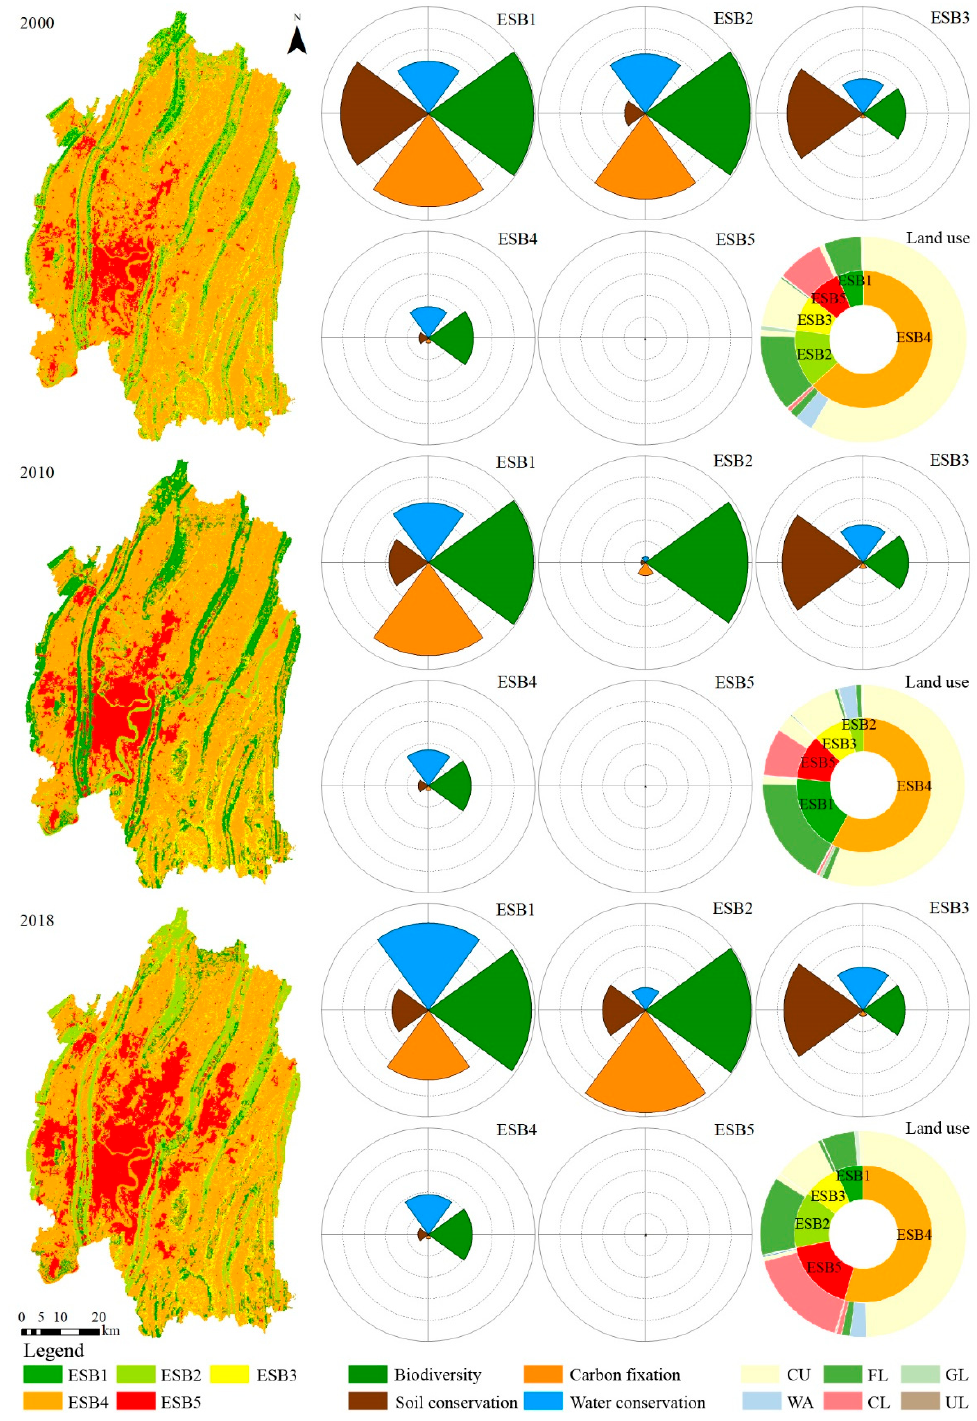
Figure 9. Spatiotemporal distribution, standardized mean ES values and land use composition of ESBs.